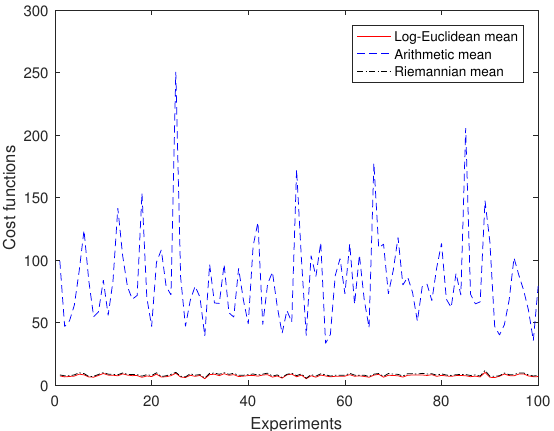
Figure 3. Comparison of cost